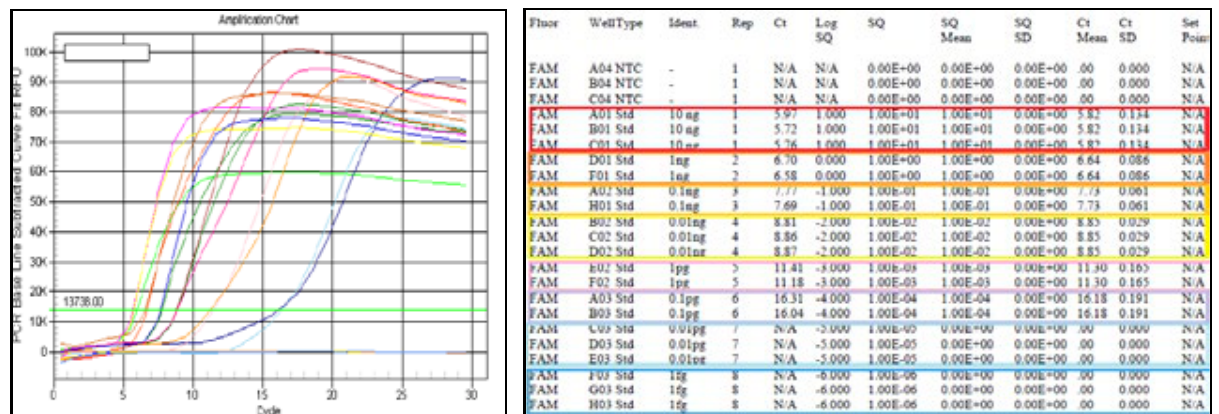
Figure 1. Real-time LAMP detection limit for DNA extracted from X. fastidiosa -DNA. A suspension of 10ng/μL DNA was serially diluted in distilled water. All dilution higher than 0.01pg react positively in a maximum of 16.30 min. Xf- dilution less than 0.1pg and negative samples showed linear curves. Dilutions were tested in duplicate on a real-time IQ5 Bio-Rad